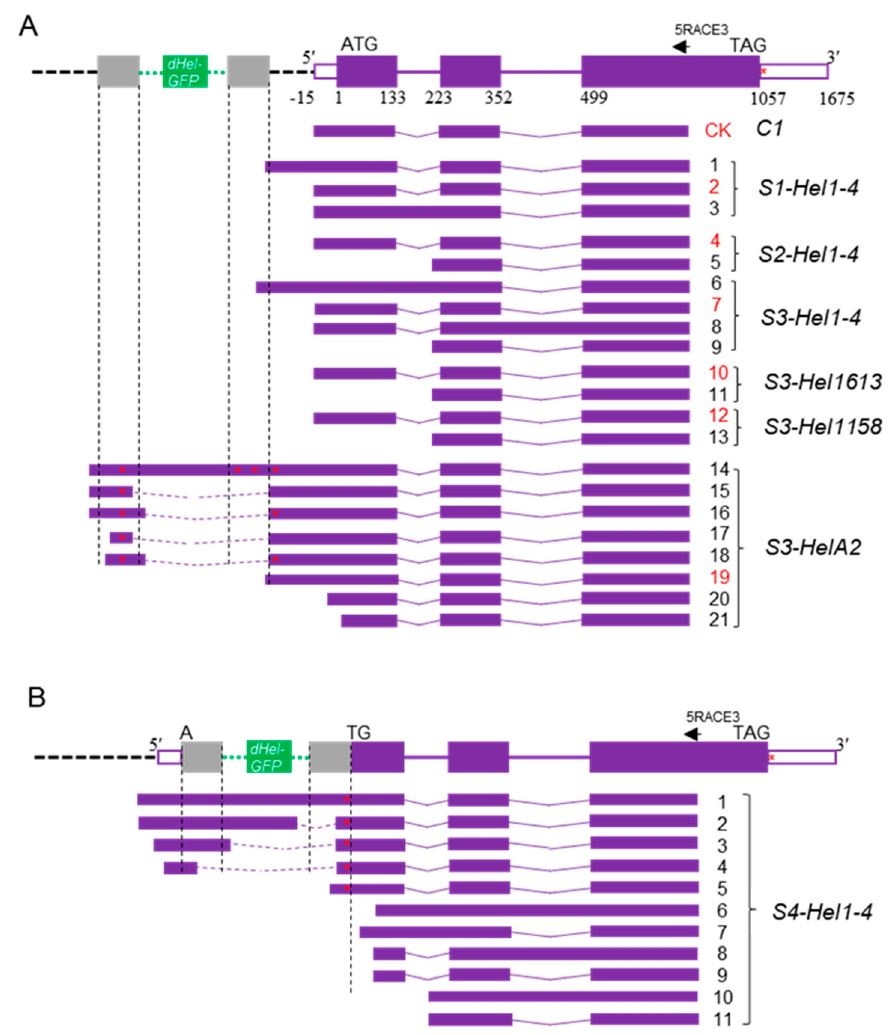
Figure 5. Schematic representation of C1 transcript variants detected by 5 ′ RACE from T 2 transgenic leaf tissue. ( A ) c1 transcripts detected in total RNA extracted from leaf tissue of T 2 transgenic plants harboring dHel insertions in the c1 promoter region (sites S1 to S3), putative wild type C1 transcripts are labeled with red numbers; ( B ) c1 transcripts detected in total RNA extracted from leaf tissue of T 2 transgenic plants harboring the dHel insertion at the translation start site of the c1 gene (site S4). GFP promoter ( α -zein promoter) and terminator (CAMV 35S terminator) are indicated by green dotted lines. LTS and RTS of dHel are indicated by dark vertical dashed lines. C1 exons and introns are indicated by purple boxes and lines respectively. The corresponding intron-exon junction sites are labeled with numbers beneath. C1 promoter region is indicated by black dotted line. 5 ′ and 3 ′ UTR are represented by open boxes. Alternative splicing events at non-canonical sites are shown with broken lines, whereas splicing events at canonical sites are shown with solid lines. dHels are indicated by grey boxes, and GFP is indicated by green boxes. Horizontal arrows, primer for 5 ′ RACE. Red asterisks, stop codons.